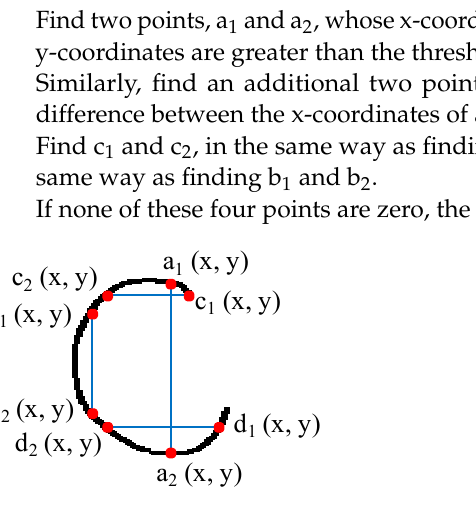
in Figure 9. In this figure, the blue segmentation lines are drawn using the labeled points. The red lines are drawn using the projection points. The 1st segment line is removed using the left open data constraint, the 6th line is removed using the closed character constraint, and the 7th line is removed using the pixel count